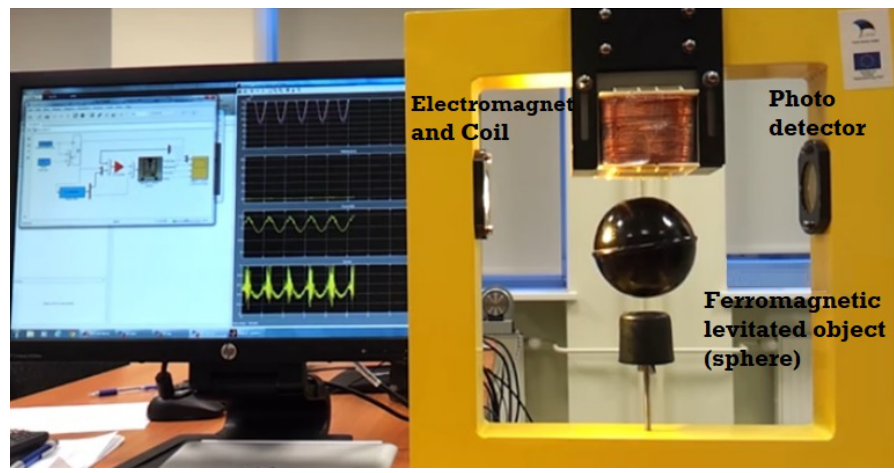
Figure 3. Magnetic Levitation System (MLS) setup in